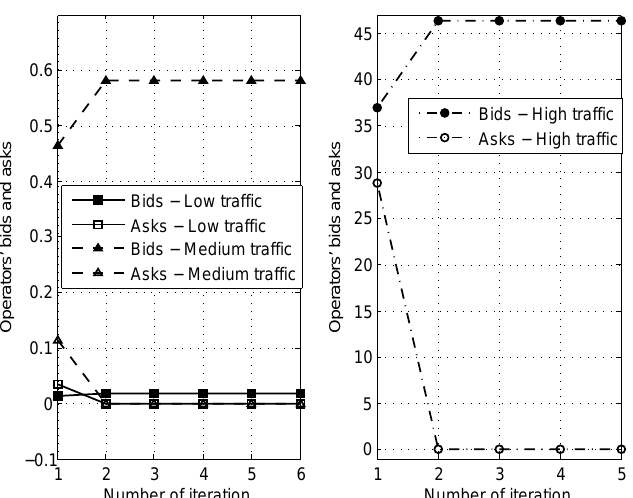
Figure 5. Evolution of bids and asks for a small market of N = 2 operators and M = 3